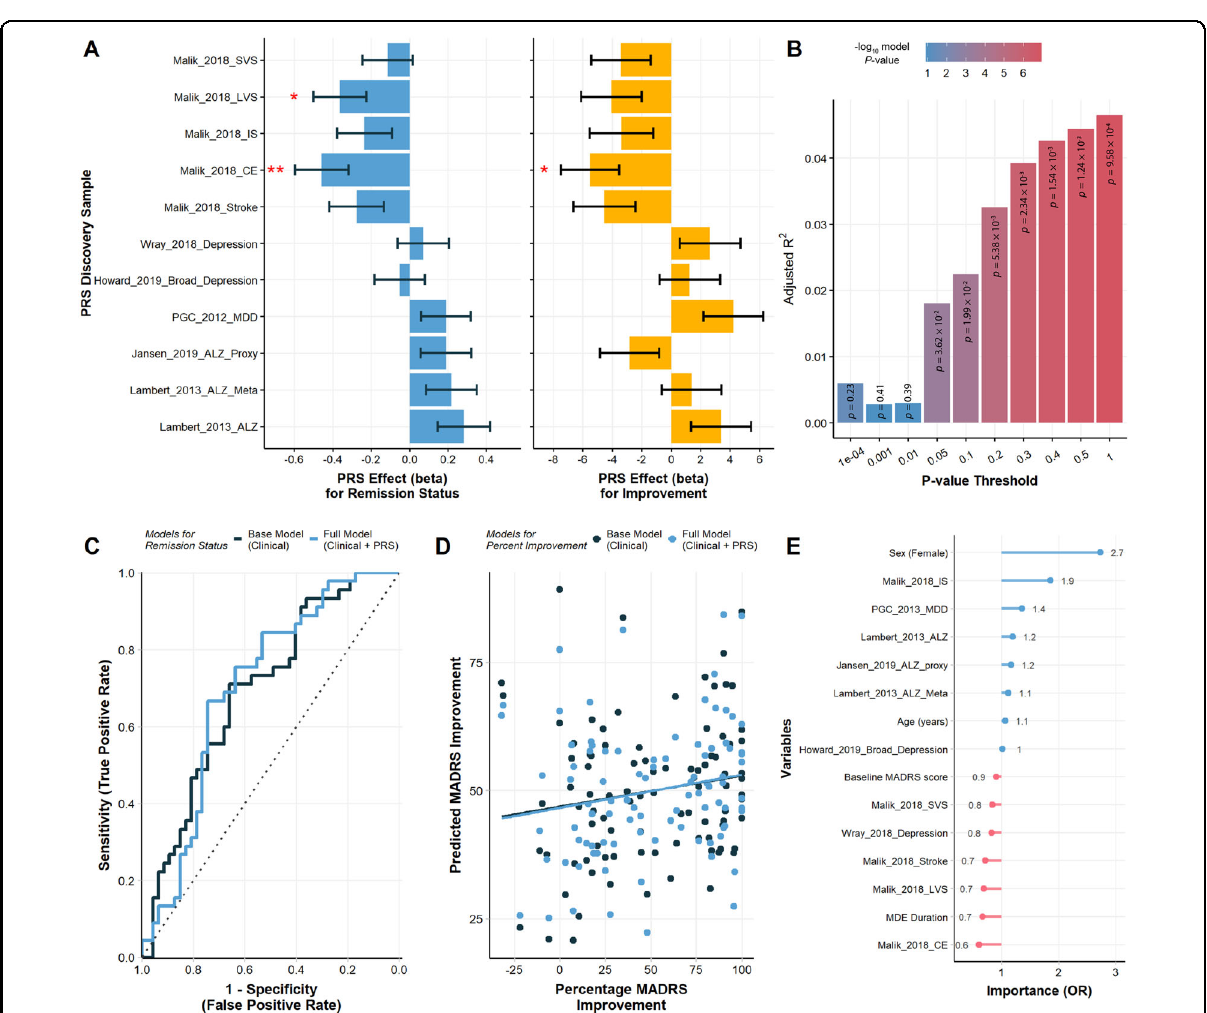
Fig. 5 Polygenic risk scores and prediction. A Polygenic risk score effect sizes for remission status (blue, odds ratios) and percentage symptom improvement (yellow, unstandardized betas). Error bars denote standard error of the mean. B Variance in remission status explained by the polygenic risk score regression results for cardioembolic risk (Malik et al., 2018). C, D Receiver operating curves for prediction of C remission status and D symptom improvement comparing a base clinical model to a model including the 11 polygenic risk scores. E Variable importance from the best performing model for remission